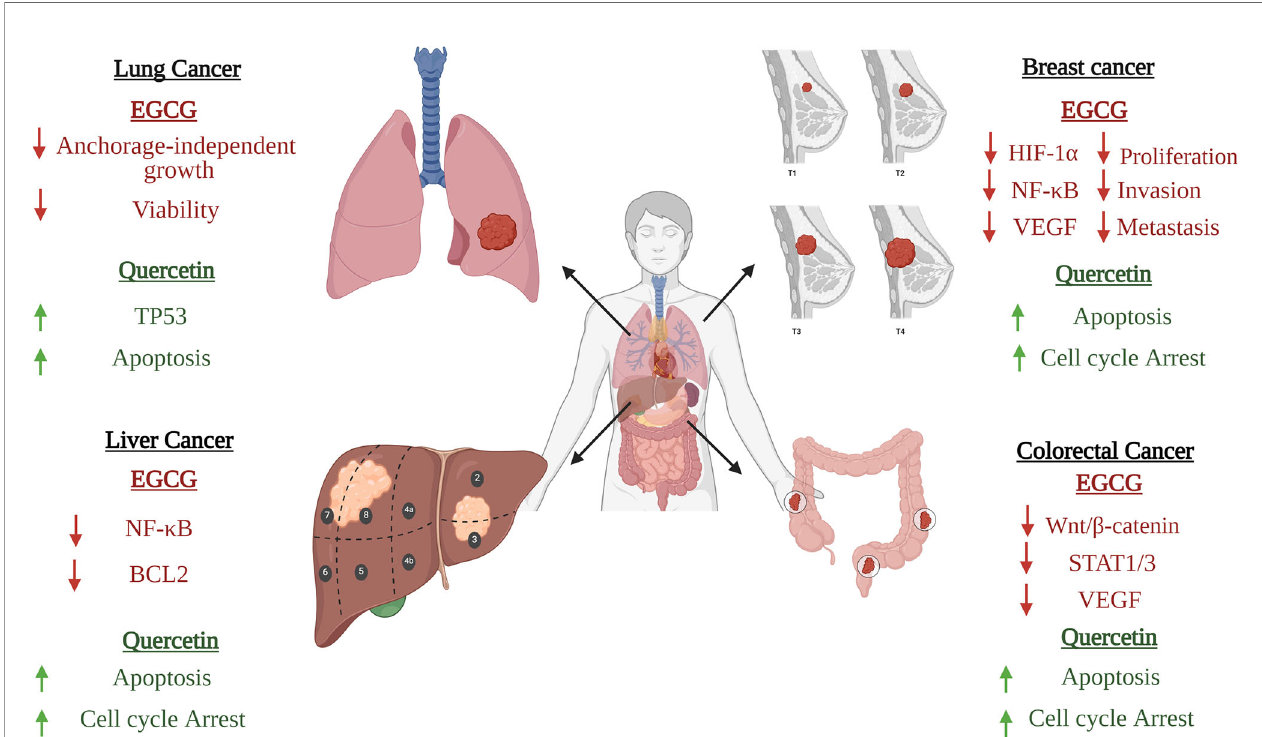
FIGURE 5 | Anticancer activities of EGCG and quercetin. Epigallocatechin-3-gallate (EGCG) and quercetin modulate several canonical oncological pathways such as Wnt/ b -catenin and JAK/STAT pathways. Also, they modulate the expression of several anti-apoptotic proteins such as BCL2, tumor suppressor proteins such as TP53, and oncogenic drivers such as VEGF. Both active ingredients have proven to be effective in halting the malignant transformation process in several types of cancers such as breast, lung, liver, and colorectal